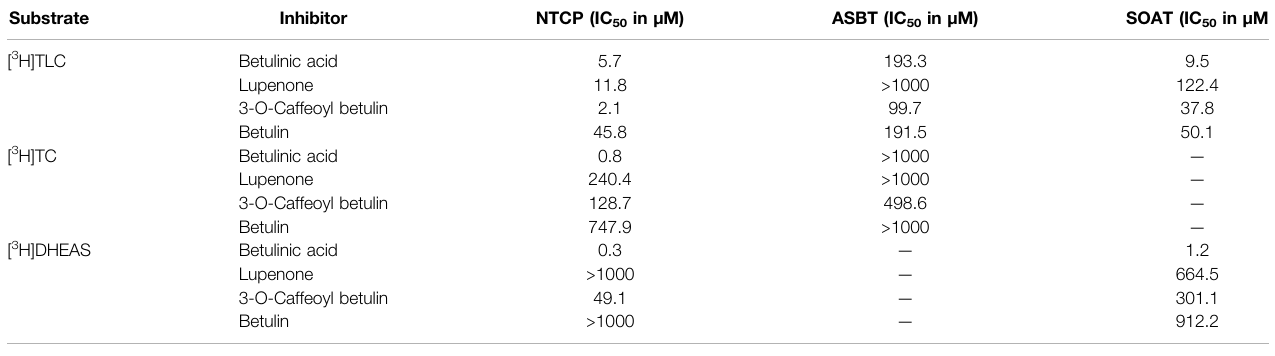
TABLE 4 | Half-maximal inhibitory concentrations (IC 50 ) for non-substrate triterpenoid inhibitors at NTCP, ASBT, and SOAT. [ 3 H]TLC, [ 3 H]TC, and [ 3 H]DHEAS substrate uptakewasanalyzedinNTCP-HEK293,ASBT-HEK293,andSOAT-HEK293cellsinthepresenceoftheindicatednon-substrateinhibitorsatincreasingconcentrations. The primary transport data are presented in Figure 4 .